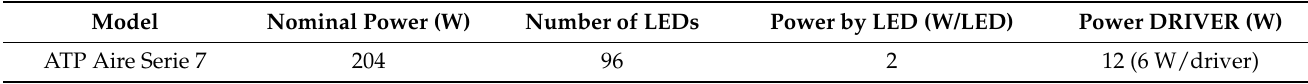
Table 6. Luminaire power table. Source: manufacturer’s data.